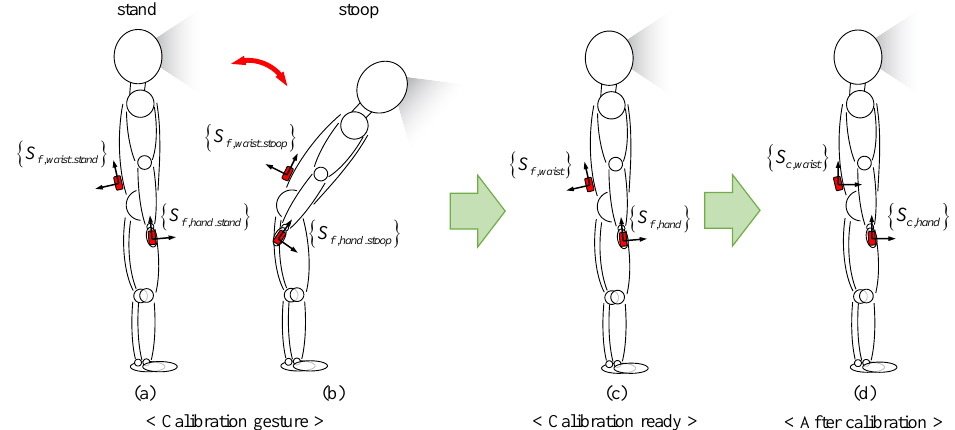
Figure 2. Overall procedure of the hand-mounted IMU sensor calibration for aligning all sensor-fixed frames equally with a waist-worn IMU sensor in this study: ( a ) standing, ( b ) stooping, ( c ) home pose or calibration-ready pose, and ( d ) measurement-ready pose after standing back.